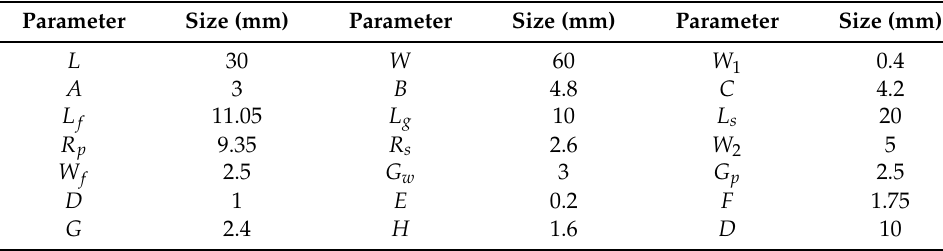
Figure 3. Equivalent circuit model of the proposed UWB/multiple-input-multiple-output (MIMO) antenna. Table 1. Different parameters and size of the